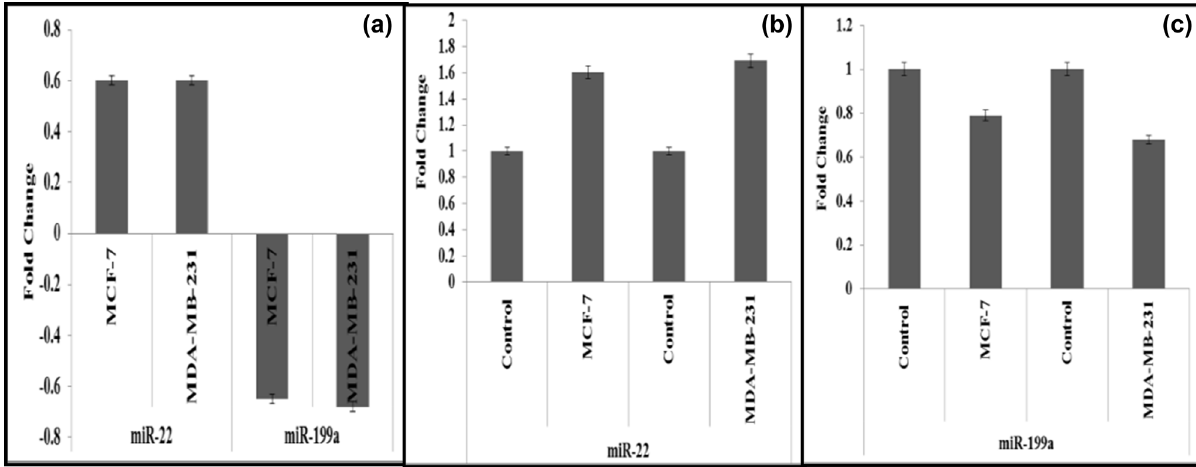
Figure 7: Comparison ofmicroarray analysiswith RT - PCRon the expressions ofmiRNA - 22 and miRNA - 199a*. MCF - 7 and MDA - MB - 231 cells were exposed to AA for 48h. ( a ) Microarray analysis; the fold changes of AA - regulated miRNA - 22 and miRNA - 199a* compared with untreated controls. ( b ) RT - PCR con fi rmation of miRNA - 22 expression compared with normal control values ( mean fold change ± SE ( n = 3 ) , P < 0.05 ) . ( c ) RT - PCR con fi rmation of miRNA - 199a* expression compared with normal control values ( mean fold change ± SE ( n = 3 ) , P < 0.05 ) .